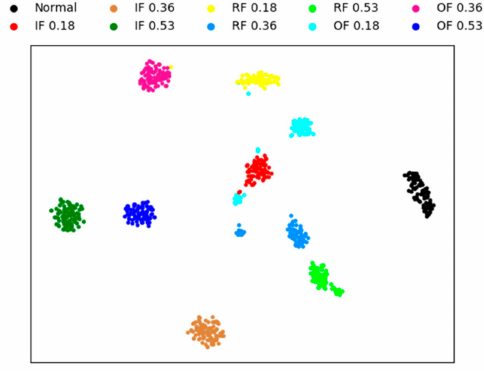
Figure 11. Visualization of proposed method for the learned